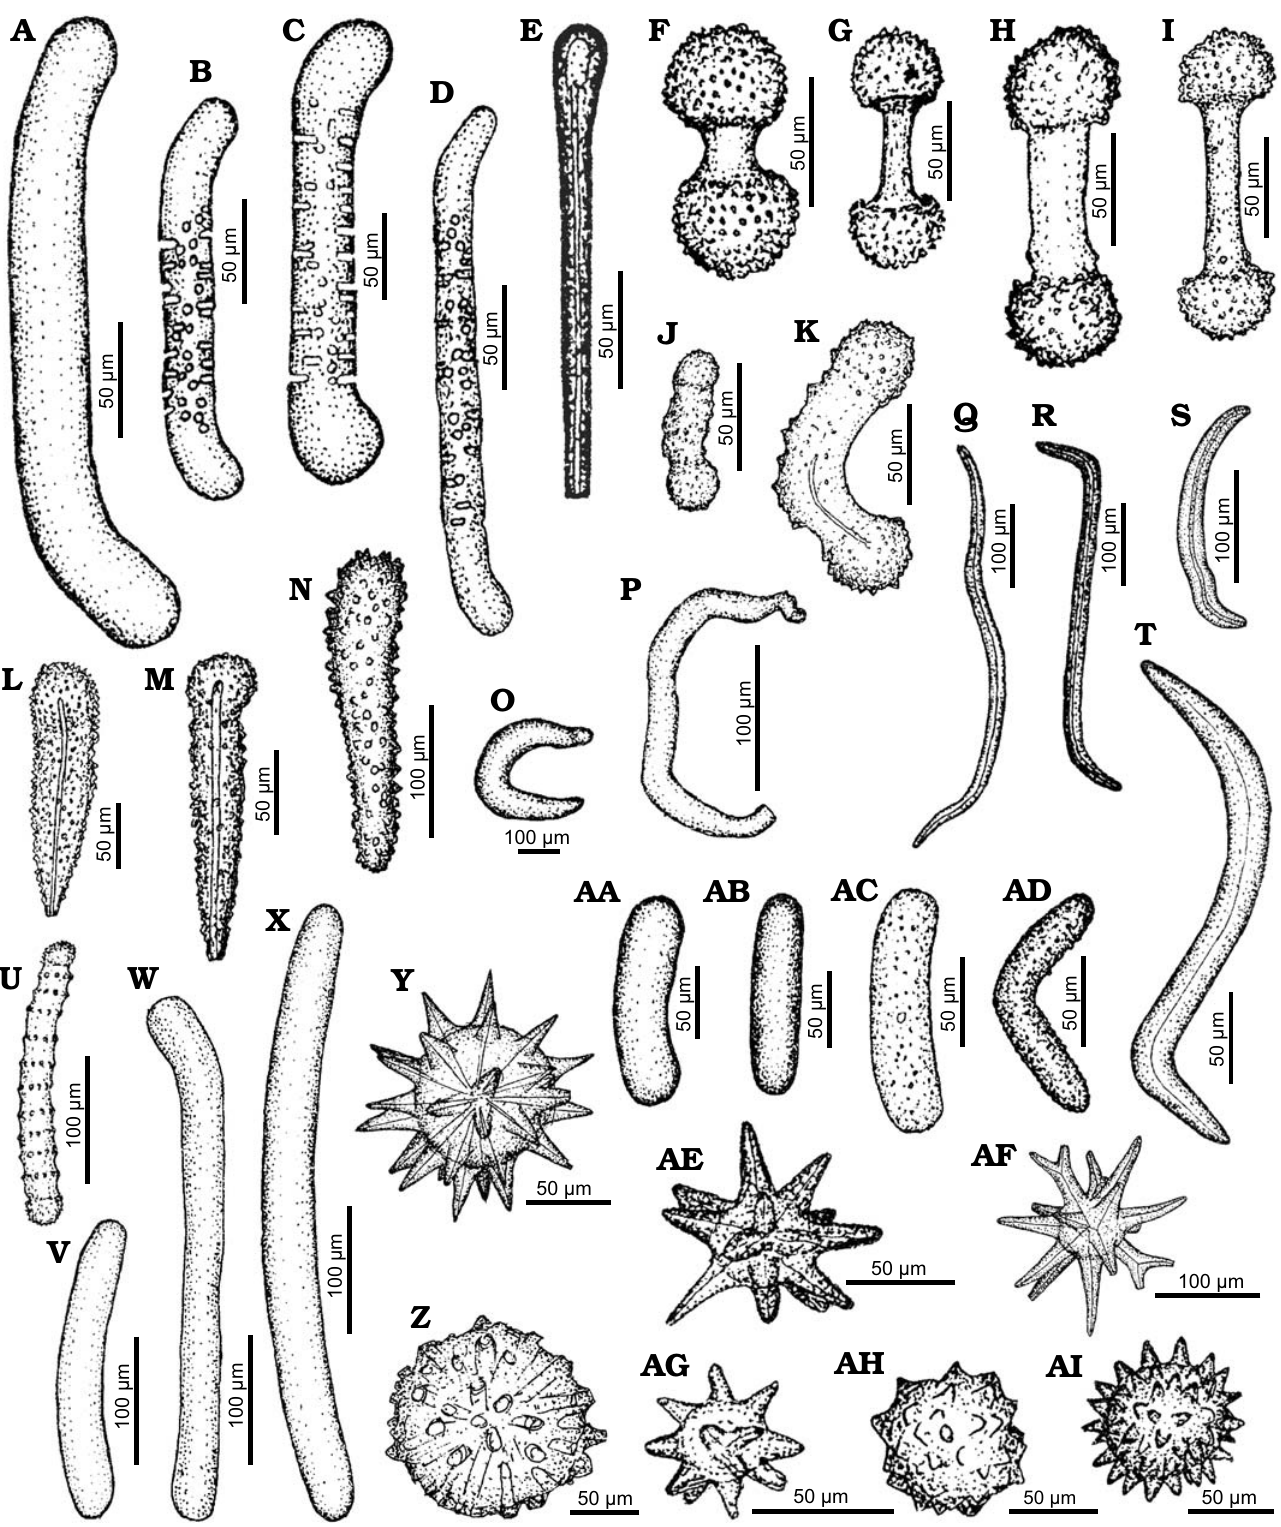
Fig. 5. Spicule morphotypes from south-central Ukraine; Kiselevka, upper Eocene (A, E, N, V, X), Russkie Ti ŝ ki, middle Eocene (B, C, F, G, I, J, M, AA), Markovka, middle Eocene (D, H, Q, R, W), Melovoe, upper Eocene (K), Nikol’skoe, upper Eocene (L, P, AF), Staroverovka, middle Eocene (O, Y, AI), Markovka, upper Eocene (S, U, AD, AE, AG), Pes č anoe, upper Eocene (T), Harkov region, middle Eocene (Z), Kantemirovka, upper Eocene (AB), Russkie Ti ŝ ki, upper Eocene (AC), and Kiselevka, middle Eocene (AH). A – D , V – X . Strongyles. E . Exotyle. F – K . Acanthostrongyles. L – N . Acanthostyles. O , P . Ophirhabds. Q – T . Flexuous oxeas. U . Acanthostrongyle. Y . Oxyspheraster. Z . Oxyaster. AA–AD . Microstrongyles. AE , AG . Oxyasters. AF . Oxyaster. AH , AI . Spherasters. After Ivanik (2003);